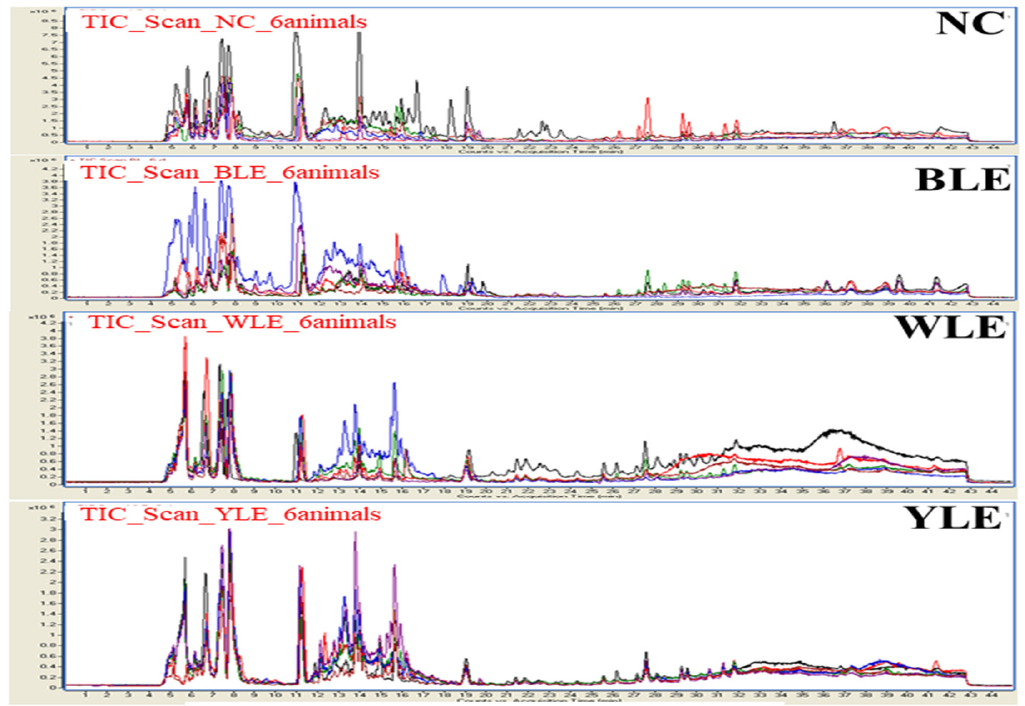
Figure 2. Representation of the spectral features of metabolite peaks obtained in controls (NC), blue light exposure (BLE), white light exposure (WLE), and yellow light exposure (YLE) groups separately. The spectral color of the chromate gram represents each animal from the same group. The X -axis represents the count versus acquisition of the metabolites’ time in minutes, and the Y -axis represents the generated distinct peaks on the total ion chromatogram (TIC) traces ( × 10 6